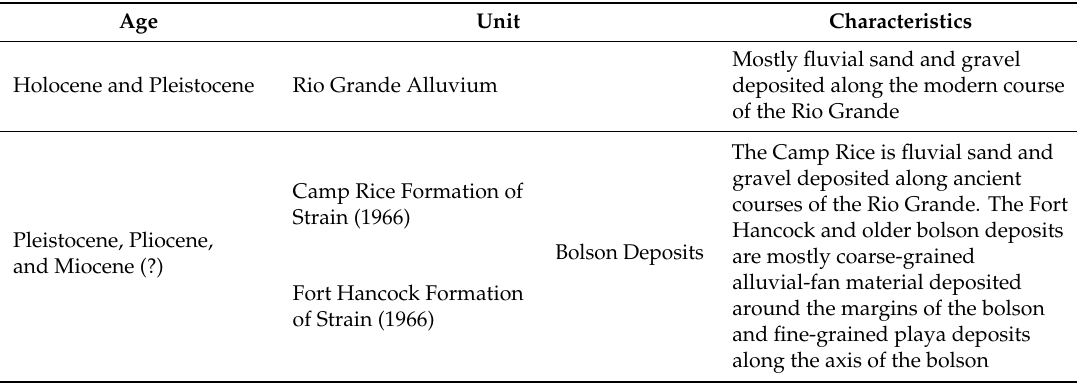
Figure 2. Salinity of the Rio Grande Aquifer in El Paso County, Texas. Alluvial aquifer salinities mapped by Alvarez and Buckner, 1980 using dense well control. The dilute groundwater near San Felipe Arroyo was thought to have formed by slope front recharge from the arroyo. Only the part of the Rio Grande floodplain in the United Section was mapped by Alvarez and Buckner [12]. The Rio Grande marks the southwestern limit of the section of the floodplain in the United States. Table 1. Unconsolidated Rocks in the Hueco Bolson (from Gates and Stanley